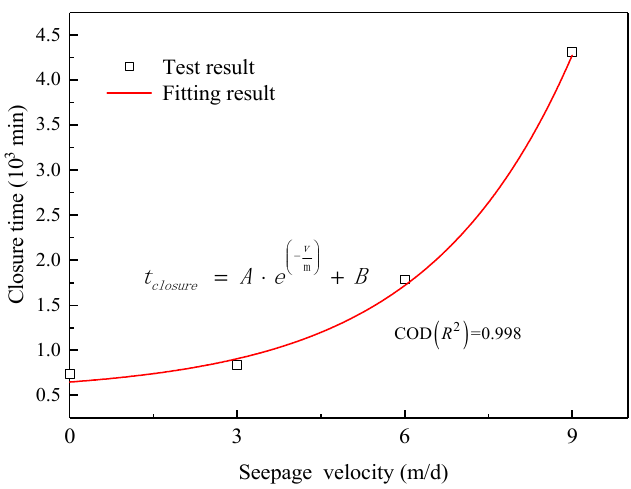
Figure 3. Fitted curve of the closure time of the frozen wall.